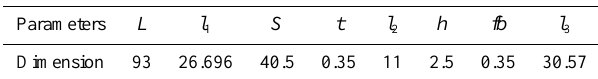
Table 1. Design parameters of the planar motion generator CMDA (unit: mm).